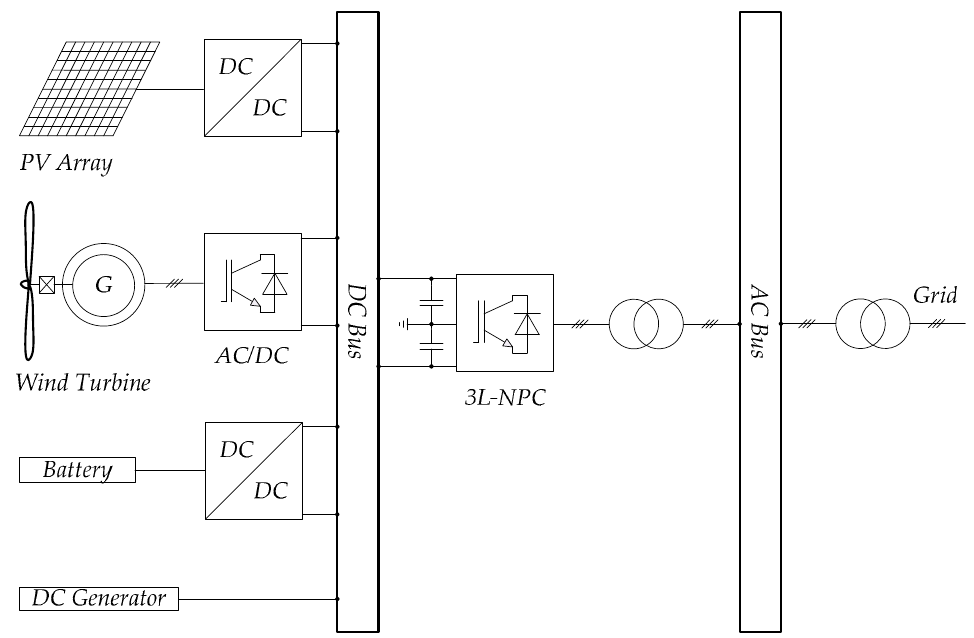
Figure 1. Configuration of distributed grid system based on 3L-NPC inverters.